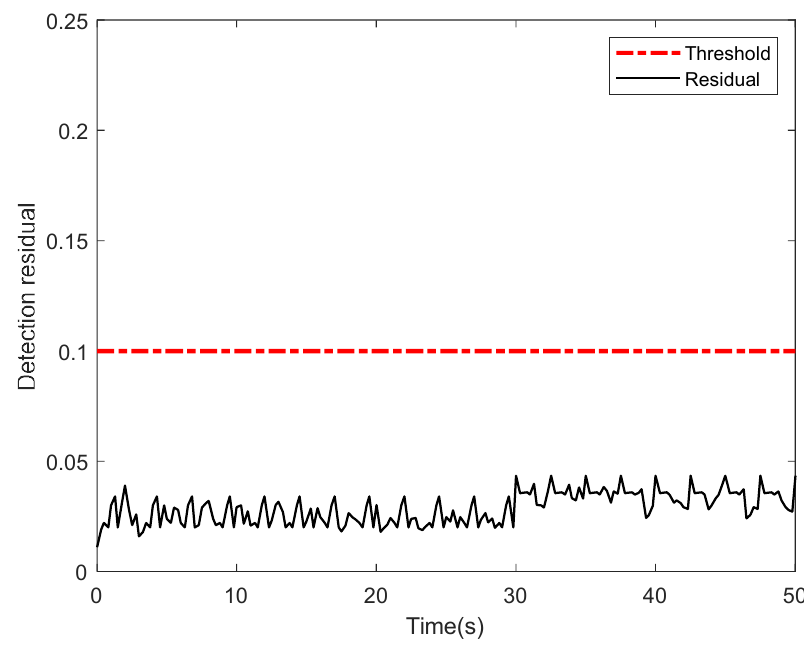
Figure 2. Detecting residual and threshold without fault.